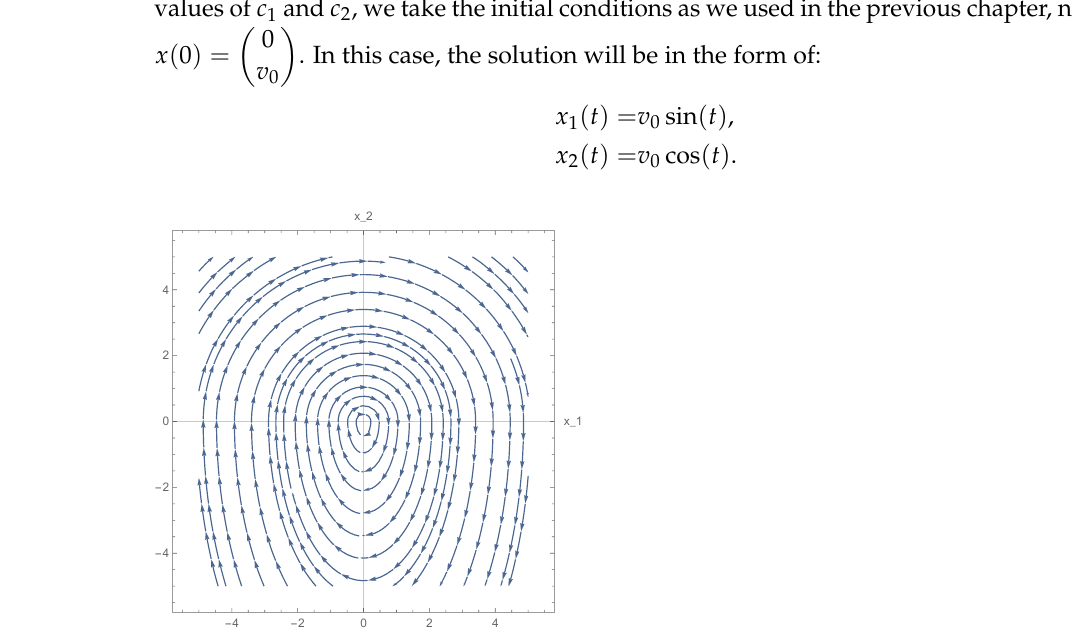
Figure 2. Local phase portrait of system